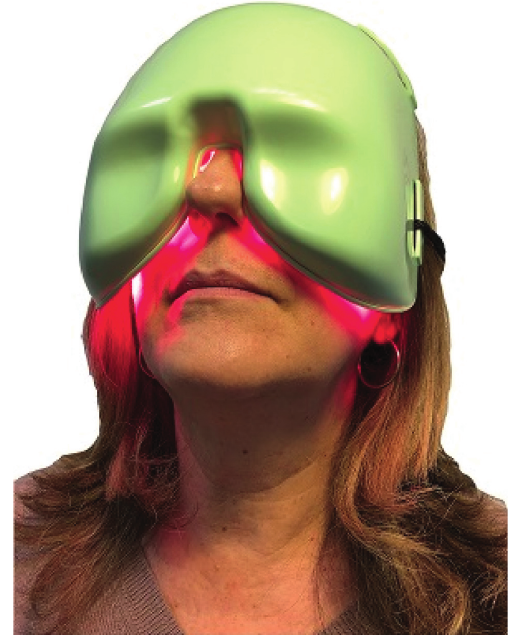
Figure 1: LLLT treatment.